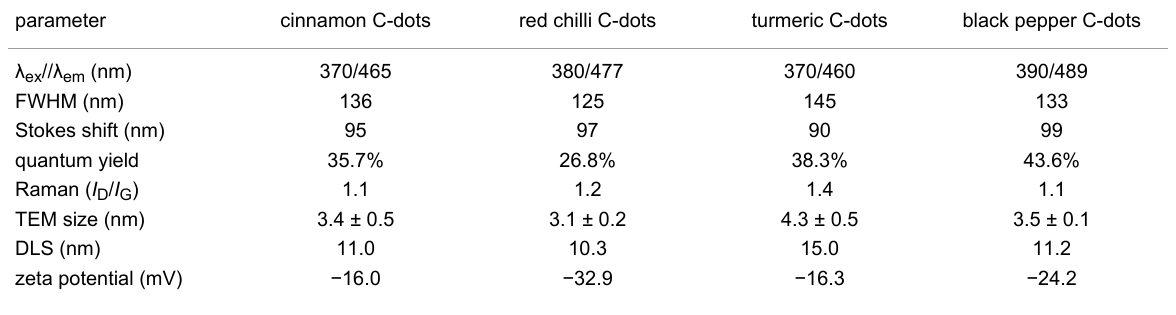
Table 1: Summary of parameters measured for characterization of the synthesized